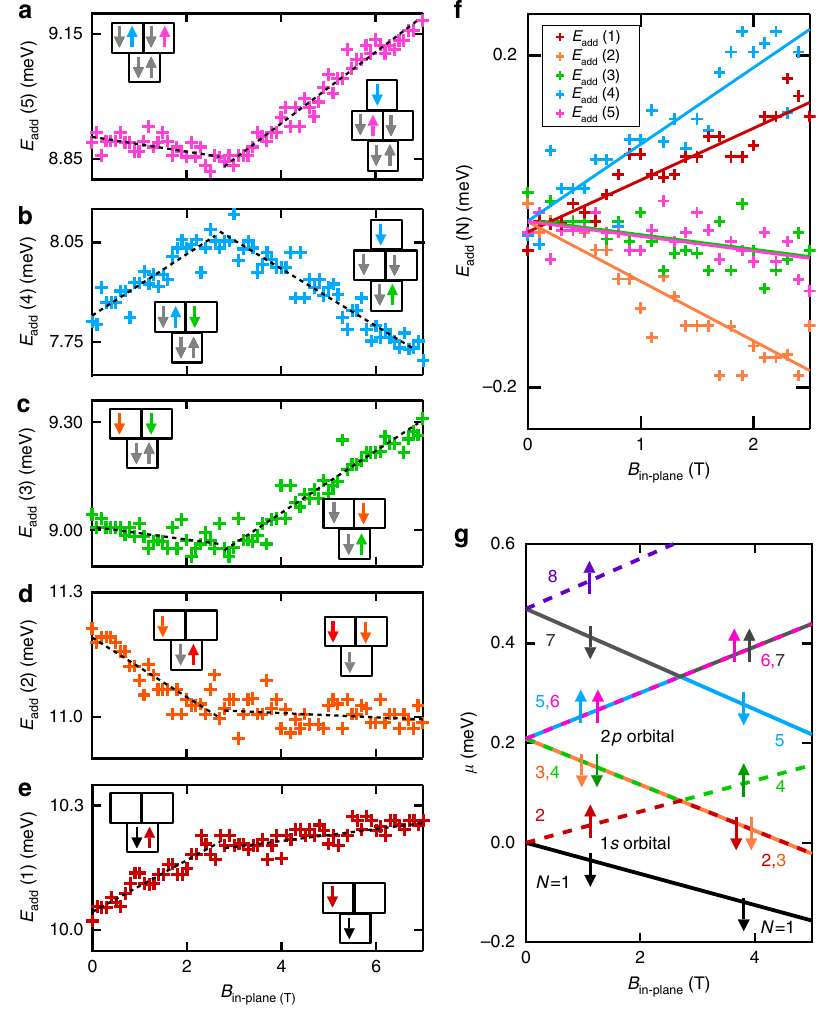
Fig. 2 Spin fi lling sequence and orbital structure. a – e Additional energy for the fi rst six holes as a function of in-plane magnetic fi eld. The N th addition energy, E add ( N ) = μ N + 1 − μ N is calculated by measuring the spacing between consecutive Coulomb peaks, that is, between the ( N + 1)th and N th peaks. The black dashed lines are a linear fi t to the raw data over the region | B | < 2.7 T (low fi eld) and | B | > 2.7 T (high fi eld). The left and right inset shows the inferred ground state spin fi lling for the low and high magnetic fi eld regions, respectively. Here, the vertical stacking of the squares represents the orbital sturcture. Each colored arrow corresponds the N th hole (as depicted by the colored text in g ). Since E add ( N ) measures the spacing between the μ N + 1 and μ N , only the two states relevant to the respective addition energy measurement are shown in color, all other states are gray. f The addition energies of a – e plotted over the low fi eld region with data offset to clarify the three distinct slopes, positive, negative, and close to zero. Solid lines are the same least-squares fi t to the data in a – e . The difference in the slope of E add (1) and E add (4) is due to the different orbital g *-factors. g Model of the hole orbital shell structure and energy levels for the fi rst eight holes (ignoring Coulomb charging energy), extracted directly from the data presented in a – e . Each line corresponds to the hole charge occupations in a – e , and the color of each line corresponds to the color of the numbers on the left and right of the fi gure. See Methods section